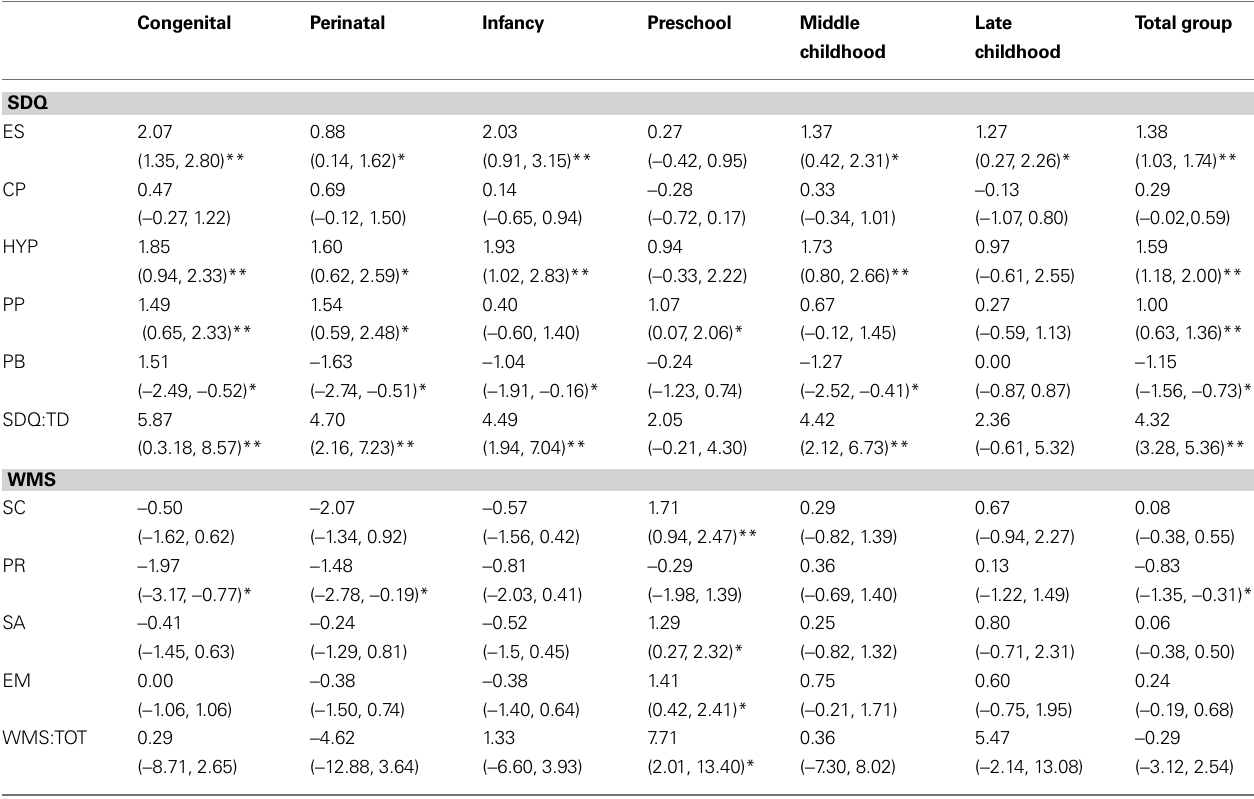
Table 3 | Comparison of EBI groups and normative data for the SDQ and WMS: mean differences and confi dence intervals. Congenital Perinatal Infancy Preschool Middle Late Total group childhood childhood